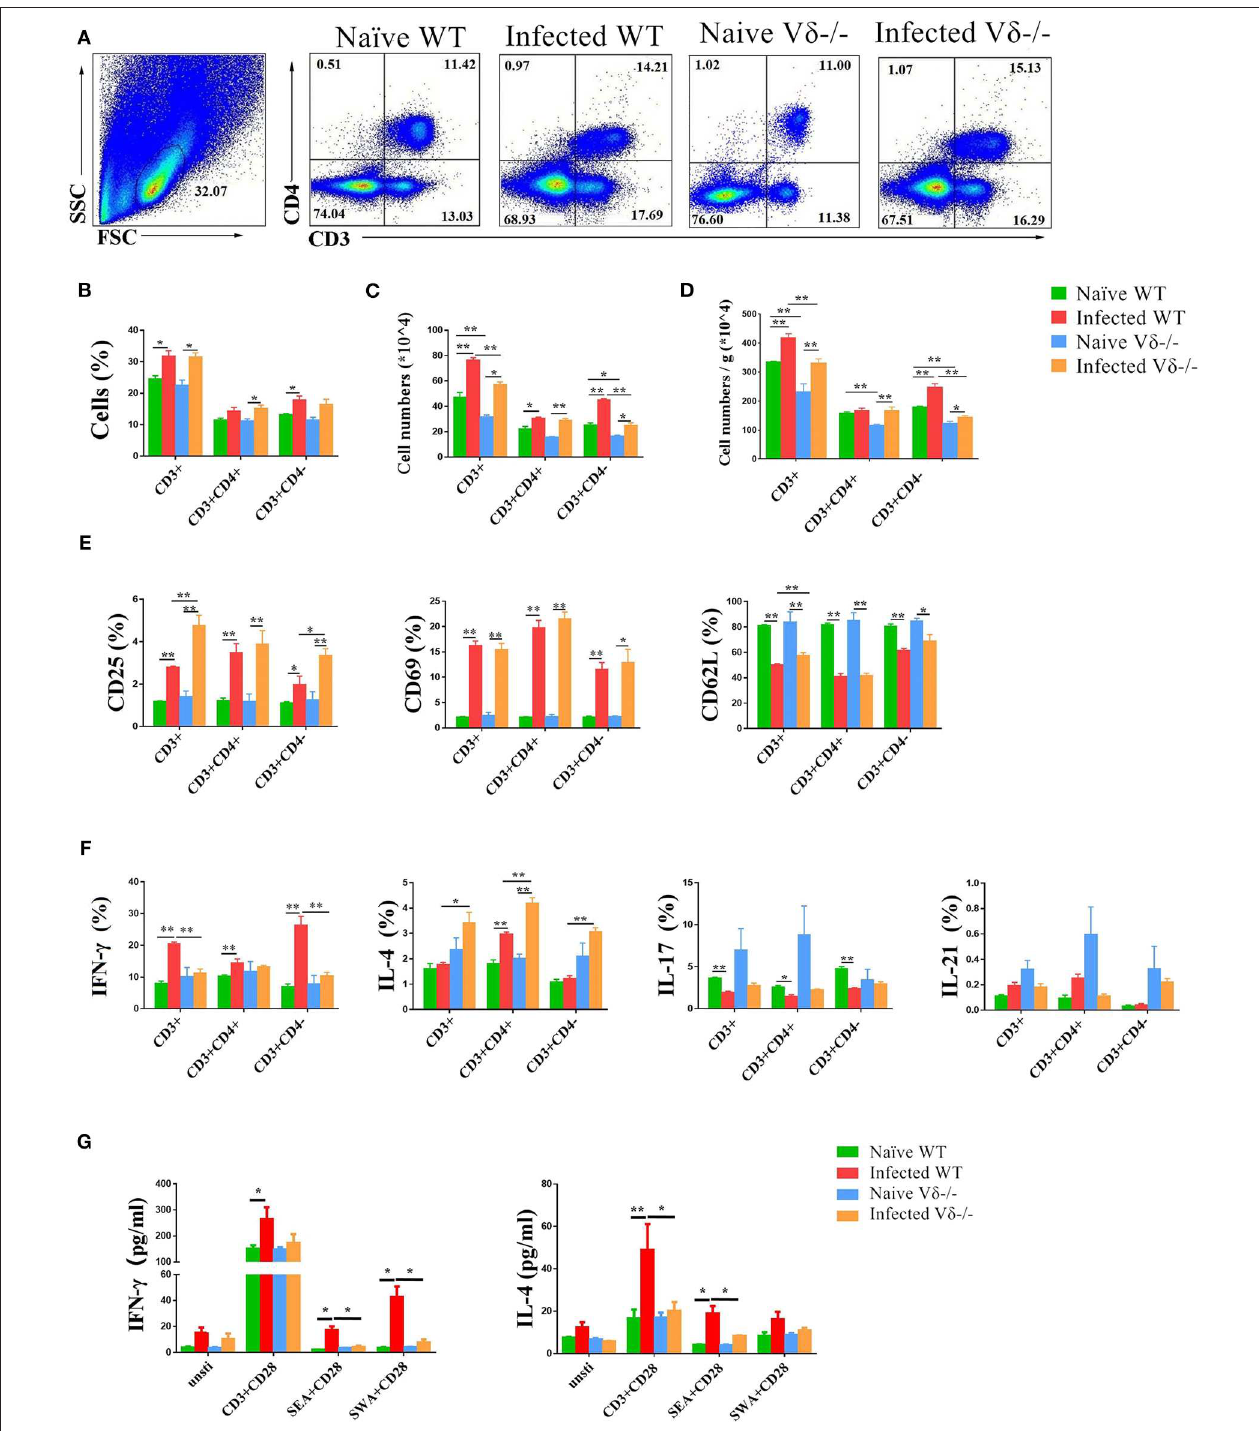
FIGURE 5 | The effect of γδ T cells on T cells. C57BL/6 and V δ − / − mice were infected with 40 ± 5 S. japonicum cercariae per mouse or not, and mice were euthanized after 5–6 weeks of infection. Single lung cell suspensions were separated. (A–D) Percentages and absolute numbers of CD3 + T cells, CD3 + CD4 + and CD3 + CD4 − cell population were counted. (E) Activation of CD3 + T cells, CD3 + CD4 + T cells and CD3 + CD4 − cells in naïve and infected WT and V δ − / − mice. (F) Expression of IL-4, IFN- γ , IL-17, and IL-21 in CD3 + T cells, CD3 + CD4 + T cells and CD3 + CD4 − cells in each groups of mice. (G) Secretion of IL-4, IFN- γ , and IL-17 in the supernatant of lung cells cultured under different stimulants. Single lung cell suspensions of each group of mice were prepared and cultured in vitro with anti-CD3 + anti-CD28, SEA + anti-CD28, and SWA + anti-CD28, respectively. The supernatants were collected after 72h. The secretion of IFN- γ and IL-4 was detected by ELISA. Data represent the average of three independent experiments with 5–6 mice per group. The error bars are SD, ** P < 0.01, * P < 0.05.